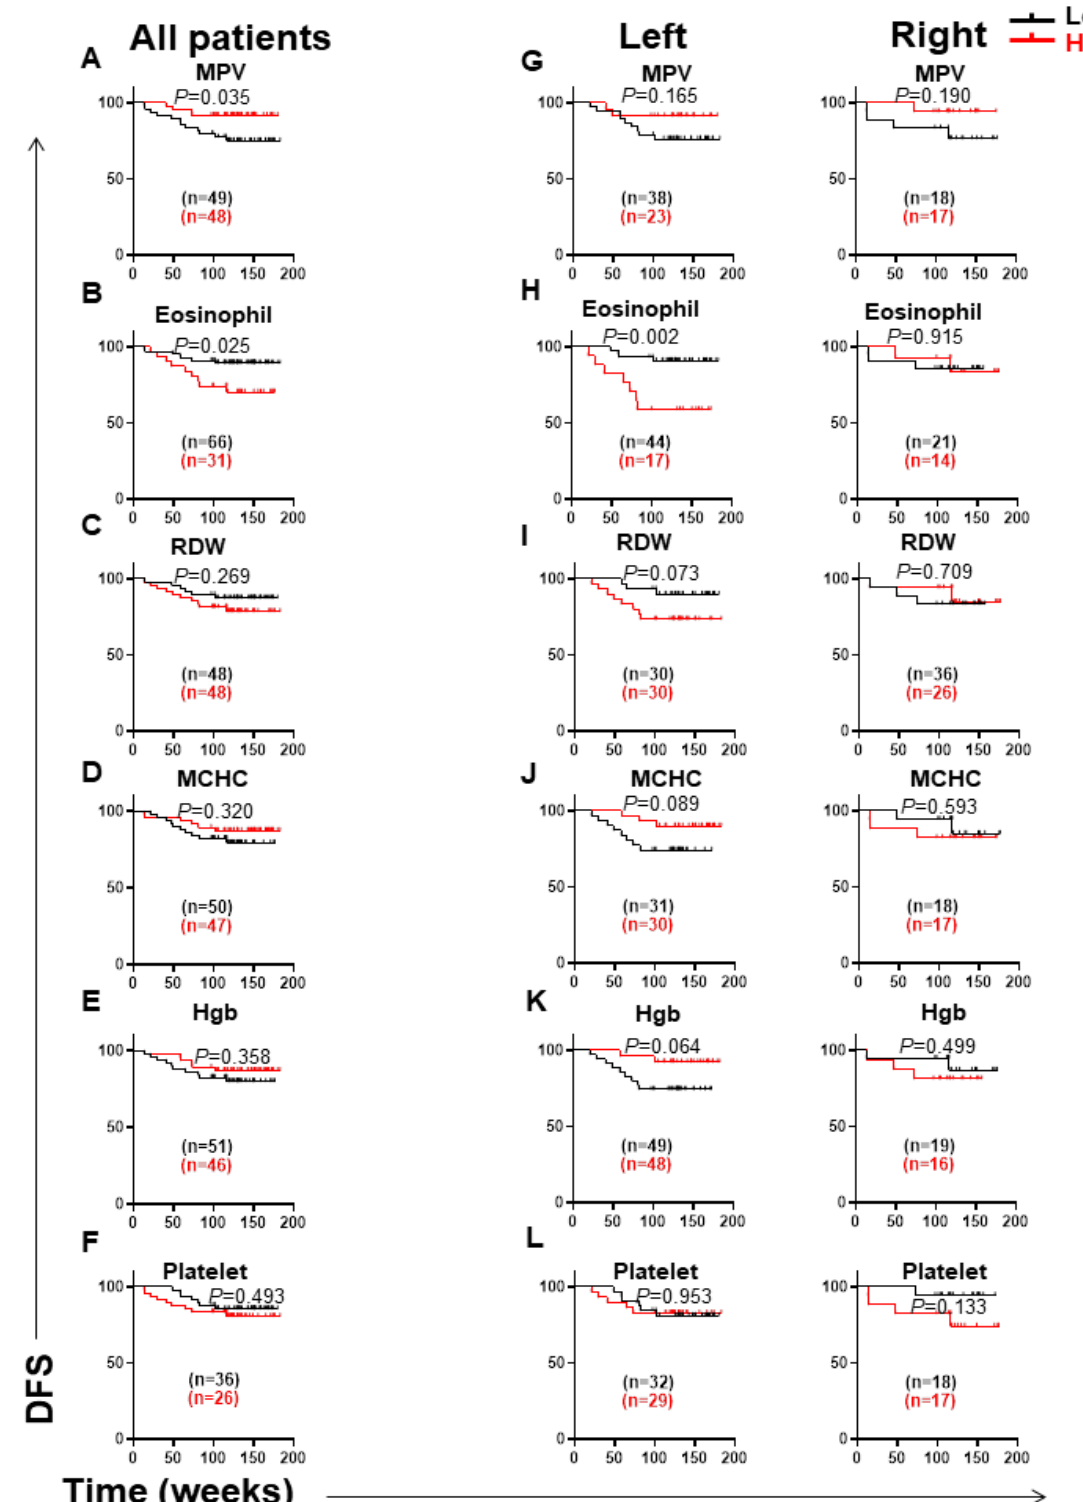
Figure 4. Kaplan–Meier curves of disease-free survival (DFS) based on different CBC parameters, including MPV, eosinophils, RDW, MCHC, Hgb, and platelet. Patients were divided into high and low groups for MPV ( A ), eosinophils ( B ), RDW ( C ), MCHC ( D ), Hgb ( E ), and platelet ( F ), and DFS was determined for these groups. Additionally, sub-analyses for left-sided and right-sided groups were performed for these six parameters, as shown in ( G – L